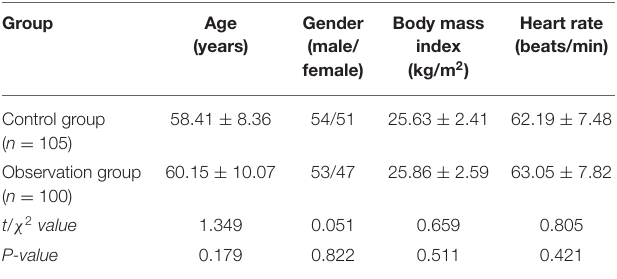
TABLE 1 | Comparison of general information between the two groups of patients ( n , x ± s). Group Age Gender (years)